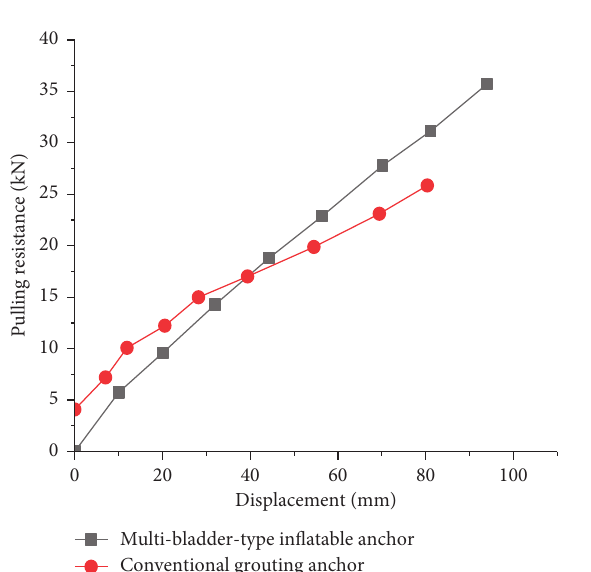
Figure 11: Comparison between the multibladder-type inflatable anchor and conventional grouting anchor.